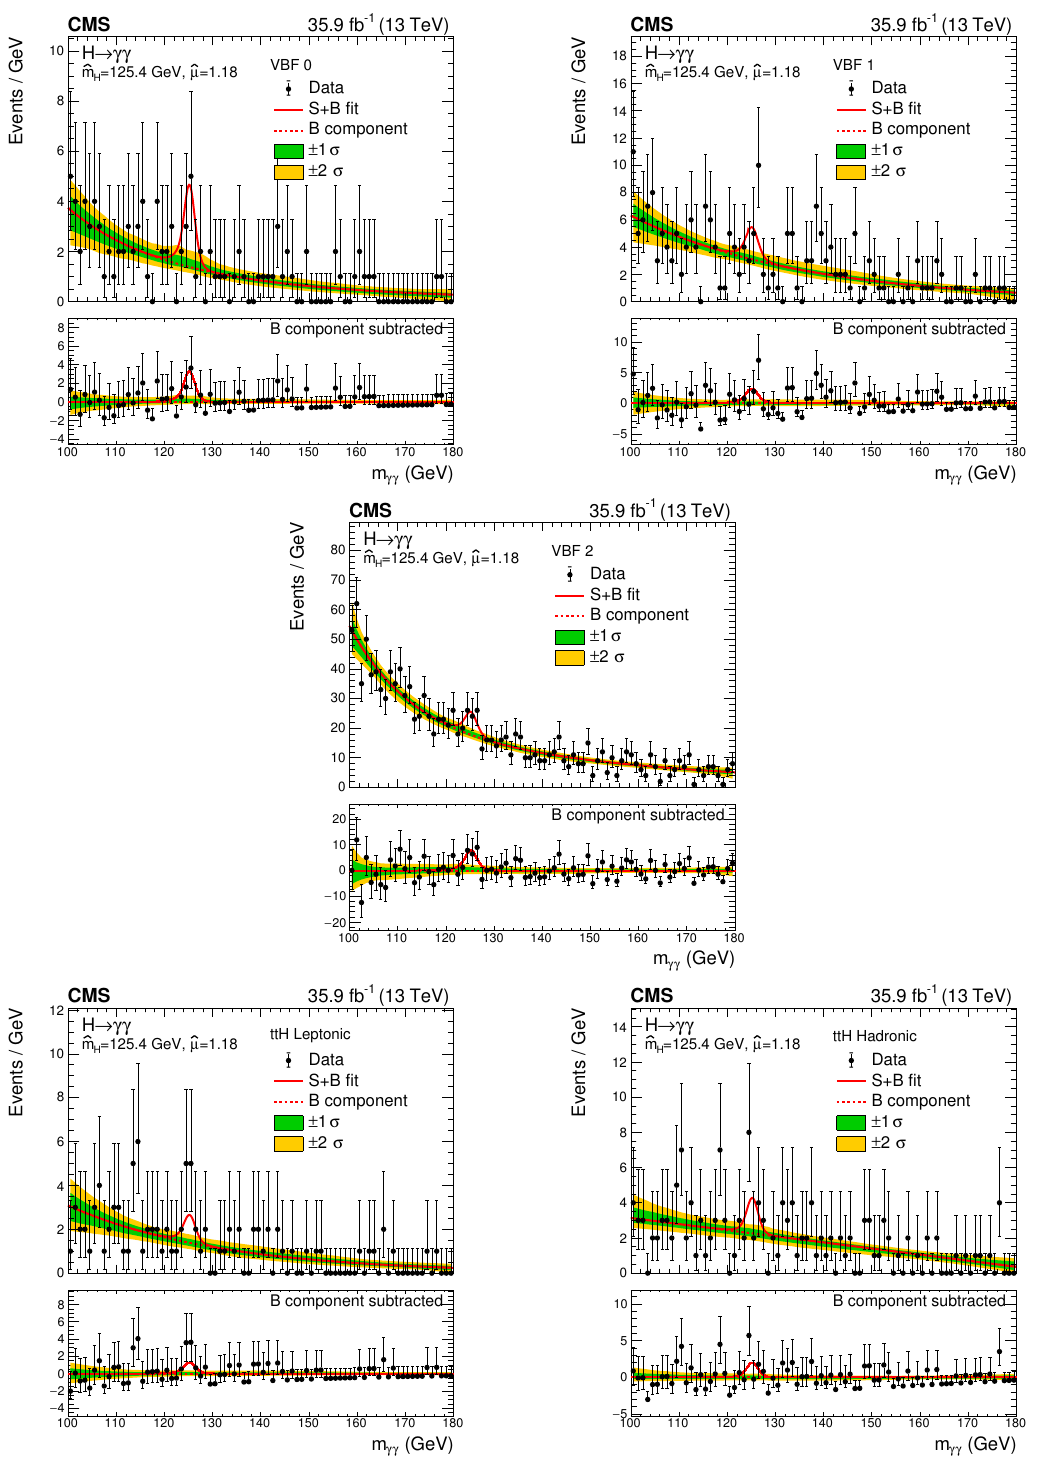
Figure 12 . Data and signal-plus-background model (cid:12)ts in VBF and ttH categories are shown. The one (green) and two (yellow) standard deviation bands include the uncertainties in the background component of the (cid:12)t. The lower panel in each plot shows the residuals after the background